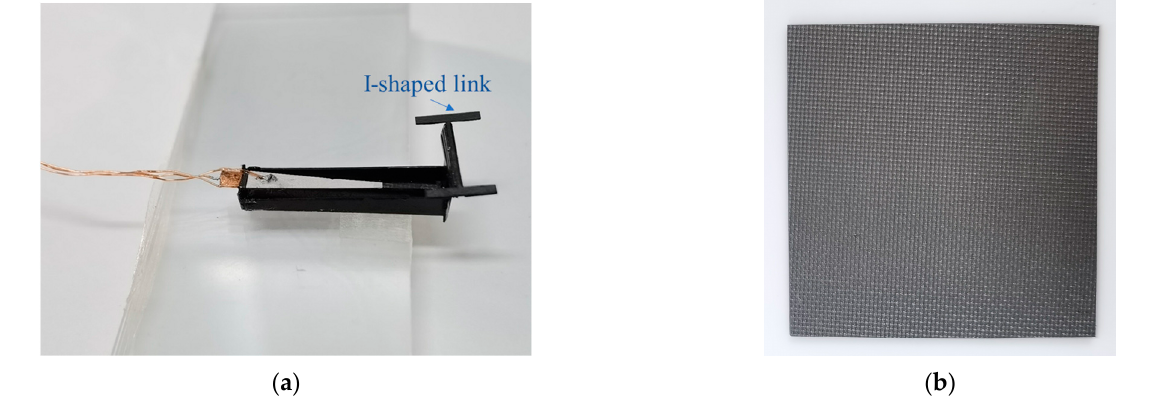
8 of 13 Figure 6. Low-voltage input current versus high-voltage output generated by the boost converter. 3. Results and Discussion 3.1. Single Squama Deflection Angle Test In this study, the processed piezoelectric actuator and the main body of the defor- mation mechanics were assembled and fixed according to the design method. The piezo- electric actuator deformation mechanics obtained is shown in Figure 7. Given a specific